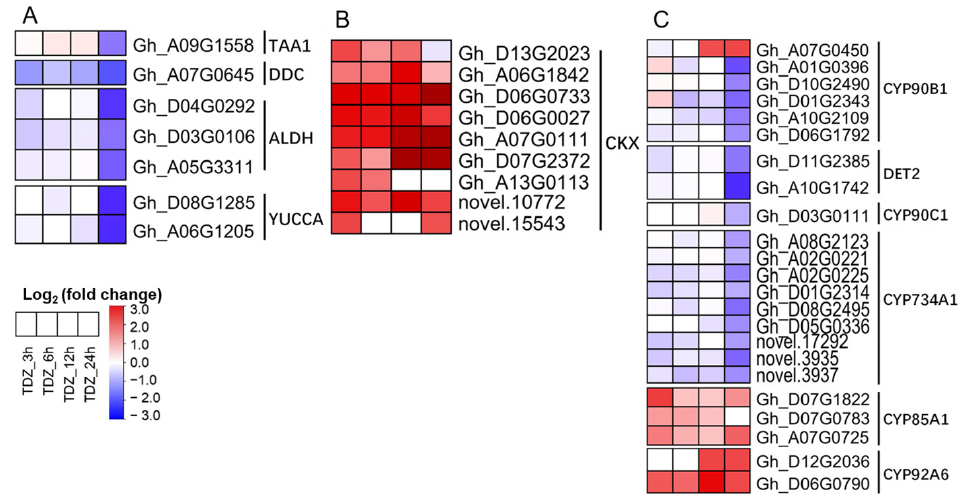
Figure 6. Genes with specific response to 300 mg/L thidiazuron (TDZ) compared with 0.6 mg/L ethephon (TDZ-SRGs) involved in auxin ( A ), cytokinin ( B ) and brassinosteroid ( C ) synthesis and/or metabolism pathways.